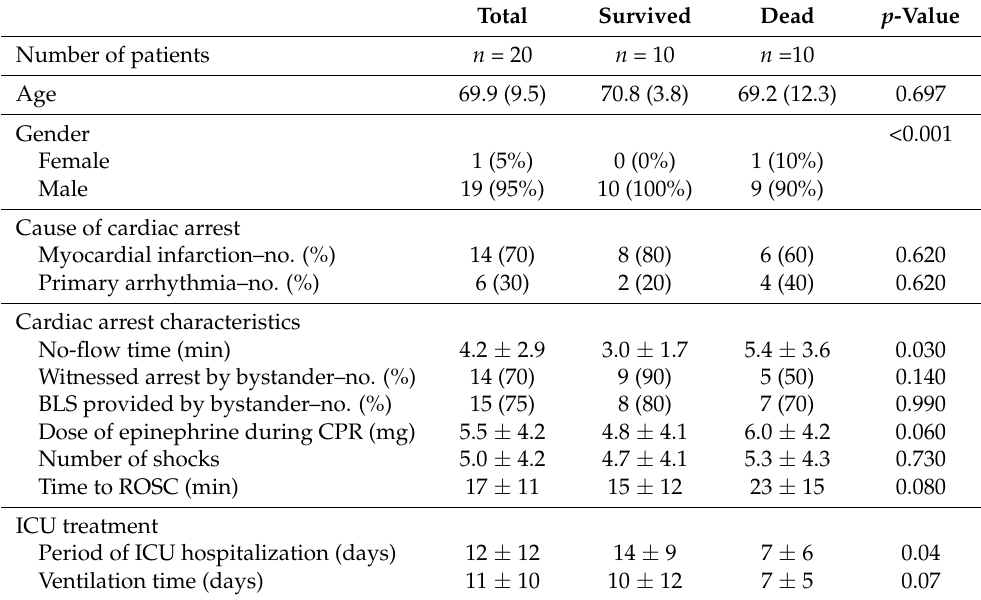
Table 1. Demographics table reporting on the different analysed variables. All of the parameters are given as means +/ − SD. For the analysis of demographic parameters, the U-test was